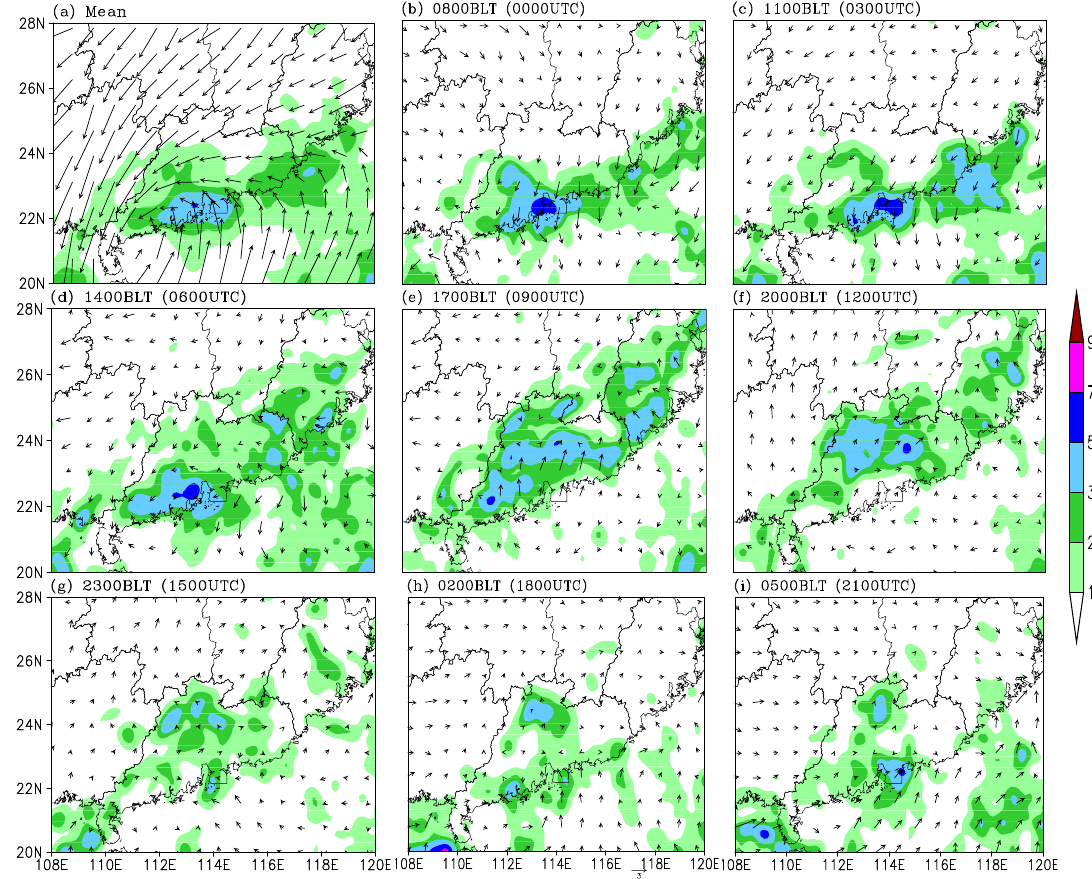
Figure 12. The results of Exp NT for mean hourly rainfall (shaded, unit: mm) and 10-m wind (contours, unit: m·s –1 ) ( a ) and the diurnal evolution of rainfall intensity (shadings, unit: mm·h –1 ) and anomalous 10-m wind (vectors, unit: m·s –1 ) at ( b ) 0800 BLT, ( c ) 1100 BLT, ( d ) 1400 BLT, ( e ) 1700 BLT, ( f ) 2000 BLT, ( g ) 2300 BLT, ( h ) 0200 BLT and ( i ) 0500